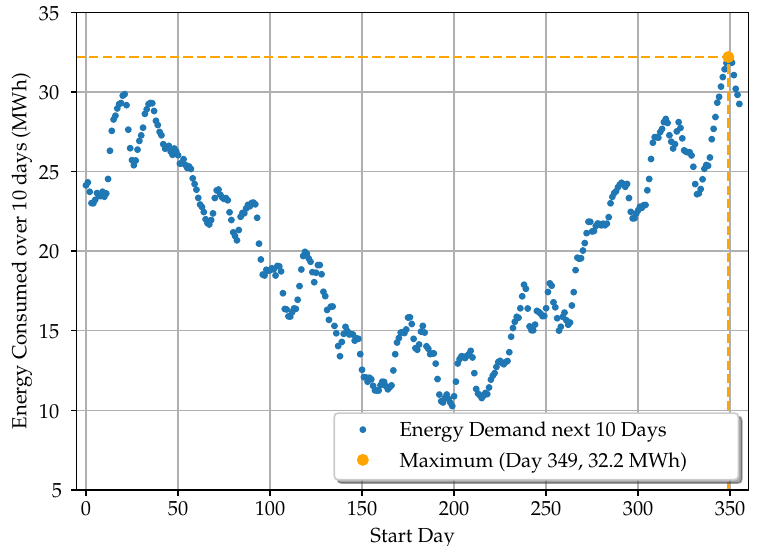
Figure 1. Energy consumed in the neighbourhood under consideration in MWh over a period starting at 0:00 on the start day and ending after ten days respectively 240 hours at 23:59 (blue dots). The maximum demand of 32.2MWh on day 349 is shown in yellow